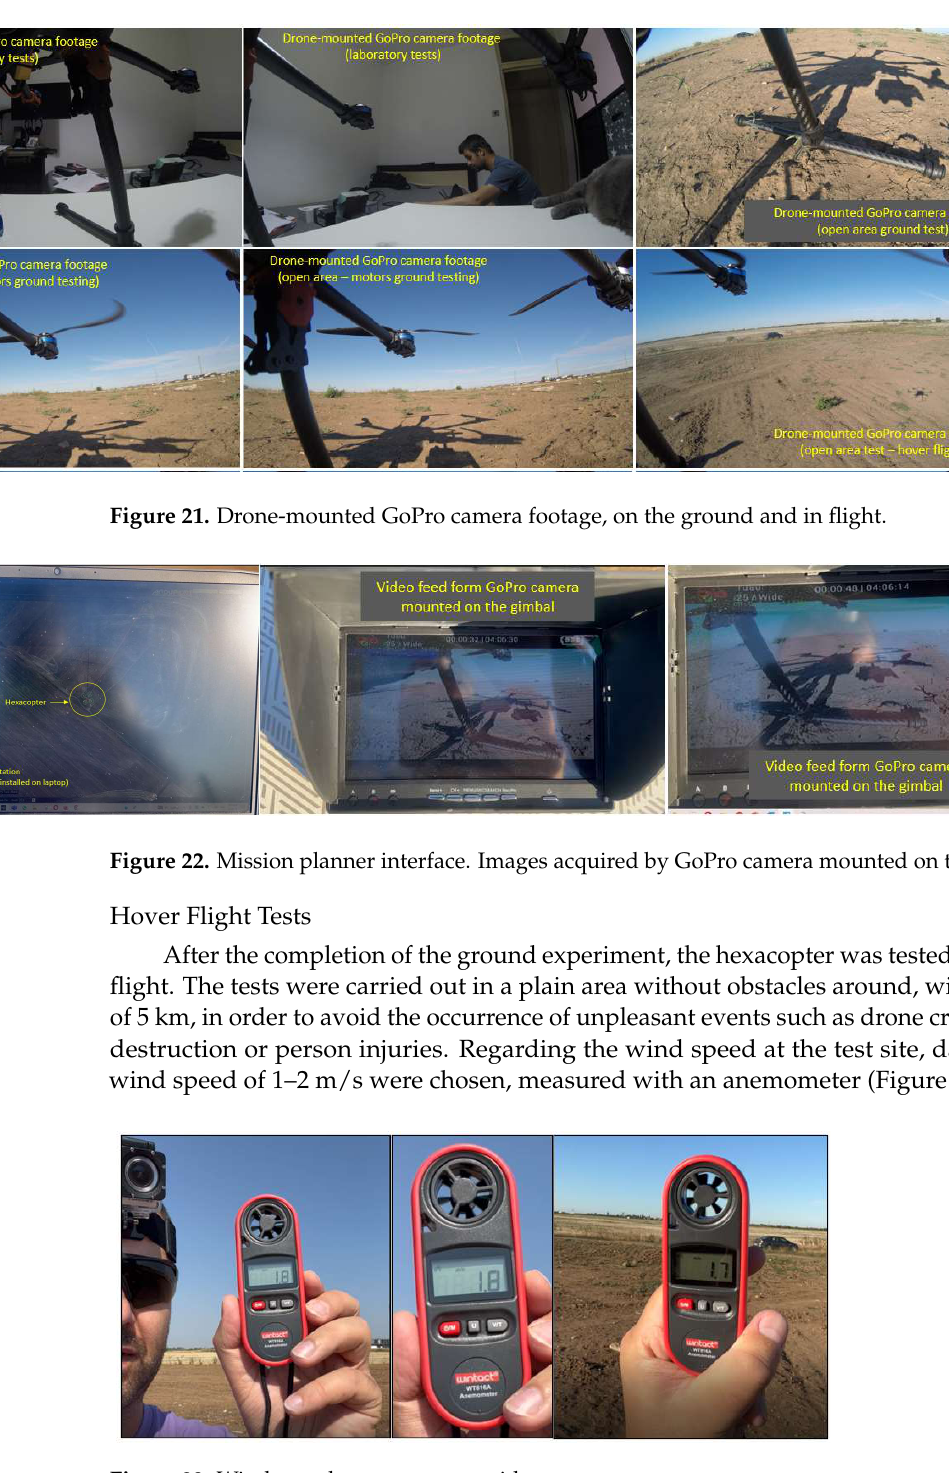
Figure 23. Wind speed measurement with anemometer.